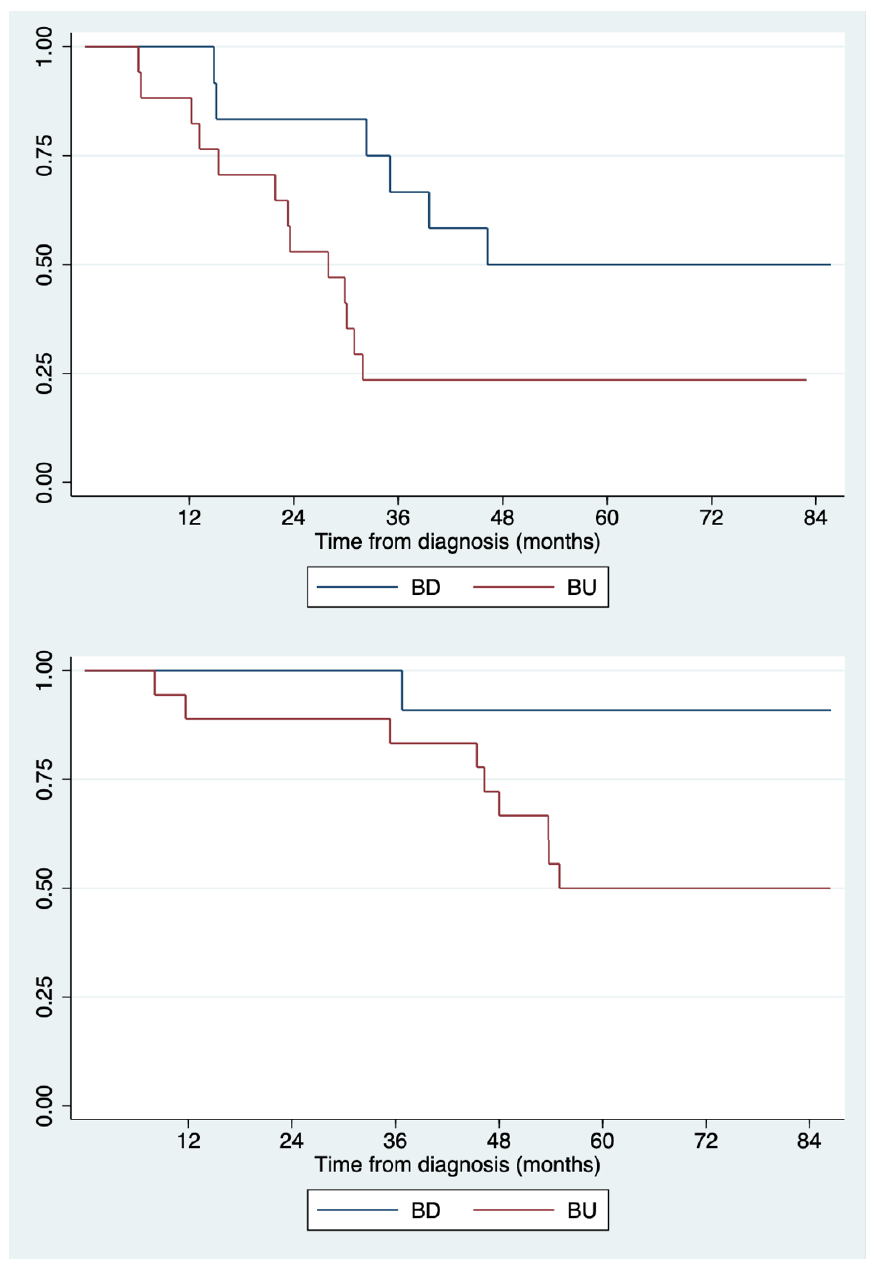
Figure 2. Kaplan – Meier curves illustrating PFS (above) and OS (below) in BD and BU patients. PFS = Progression Free Survival; OS = Overall Survival; BD = BRCA-deficient; BU = BRCA deficit undetected/unclear.